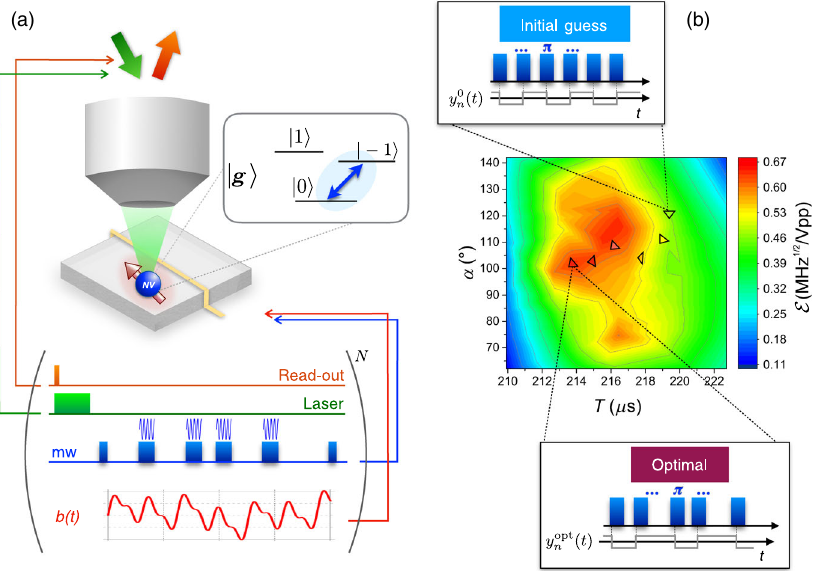
FIG. 1. One-qubit optimization strategy. (a) The electronic spin of a single NV center is optically initialized in the j 0 i state and read out after the sensing period by means of a confocal microscope. An antenna delivers both the resonant control field (mw) and the target magnetic field b ð t Þ to be measured, in the proximity of the spin qubit. Each measurement shot is repeated N ¼ 2 × 10 5 times (see also Appendix A 1). (b) Illustration of the optimization protocol. The starting point is an initial guess for the control sequence described by a modulation function y 0 n ð t Þ , which depends on a given number of parameters. While in the paper we consider more general cases, for the sake of simplicity, the central panel shows a search in a two-parameter space (sensing time T and phase shift α ) for a Carr-Purcell (CP) control sequence used to detect a monochromatic ac field b ð t Þ ¼ b cos ð 2 πν 0 t þ α Þ , with frequency ν 0 ¼ 20 . 5 kHz and unknown amplitude b to be measured. The map represents the experimentally measured inverse sensitivity E ¼ C= η (see text). The algorithm computes the sensitivity η under the initial control sequence and then produces and evaluates a number of other trial points y ð moves in the multidimensional parameter space until global convergence is reached. The final point, described by y opt n , represents the optimal control